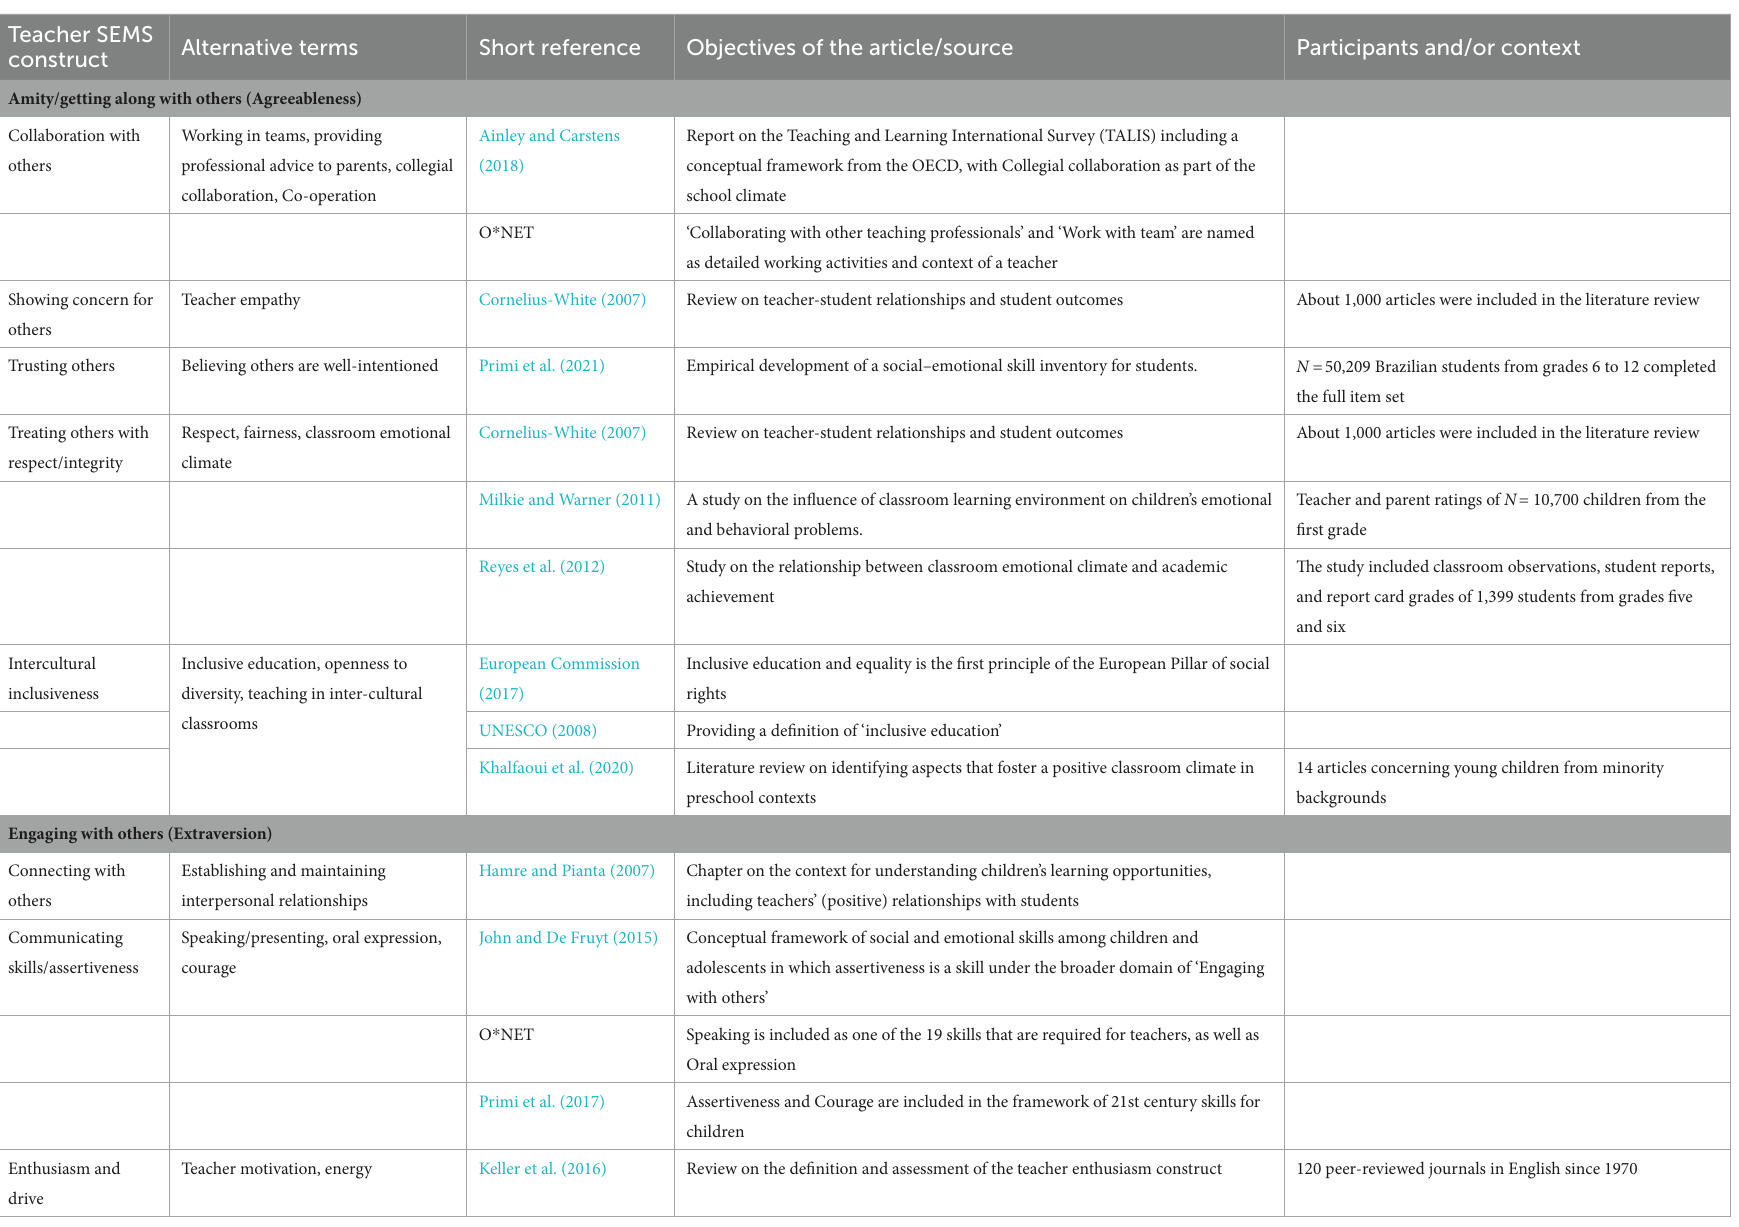
TABLE 1 Overview table of the conceptual model and the studies included in the